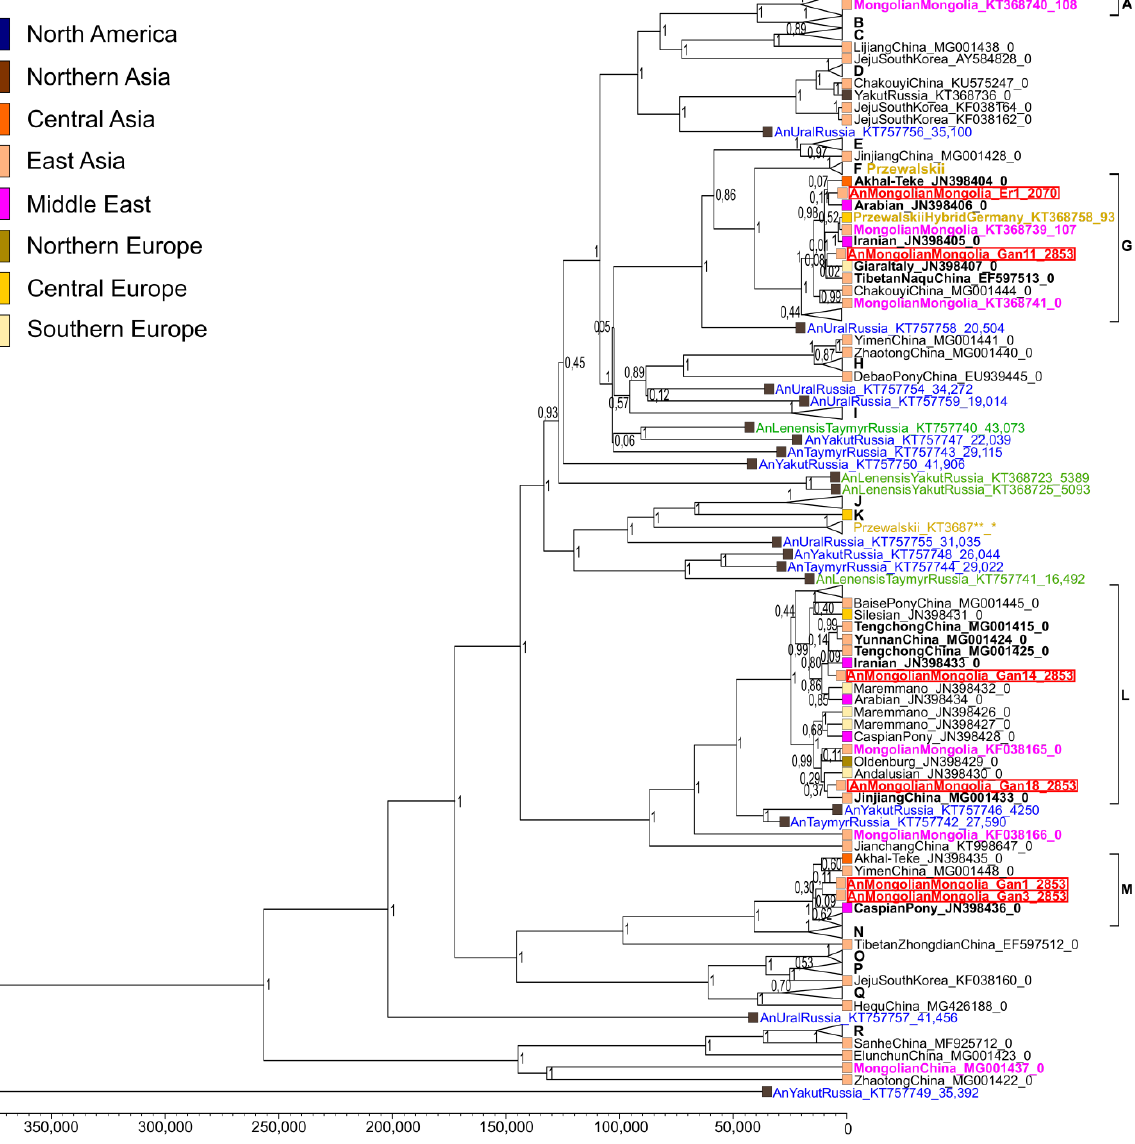
Figure 1. The Bayesian phylogenetic tree of the ancient Mongolian horses studied here and ancient and modern horses of different origins. The tree was constructed based on the alignment of 6 sequences of mitogenomes obtained here and 200 previously published ones (Table S2). Mitochondrial haplogroups A–R by classification of Achilli et al. [38] are marked in black. The red color of a sample name denotes the ancient horses of Mongolia studied here, the green color indicates those belonging to the Equus lenensis lineage, golden means belonging to Przewalski’s horse, blue denotes ancient horses outside Mongolia, pink means modern and historical (20th century) horses of Mongolia, and black indicates modern horses outside Mongolia. Sample names consist of three parts separated by underscores. The first part is a species affiliation or horse breed name and geographic origin of the sample, the second part is a GenBank accession number, and the third part is sample age. The color palette of the squares indicates the geographical origin of samples. The tree was rooted by means of a published donkey ( Equus asinus ) mitochondrial genome (GenBank accession No.: NC_001788.1) (not displayed). Numbers near the tree branch nodes indicate posterior probability of the topology obtained by the Bayesian method. The time divergence scale at the bottom of the figure is a timeline where the dates are expressed in years before the present. Tree nodes with modern horses, not considered in the Discussion section, were collapsed for better visualization.